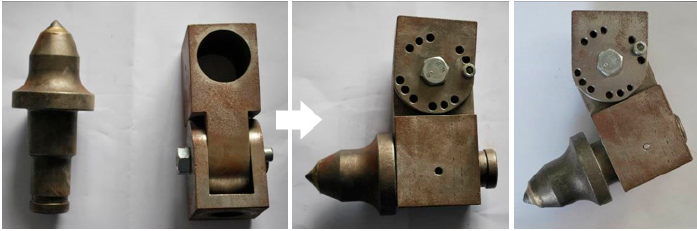
Figure 7. Figure 7. Pick-holder.